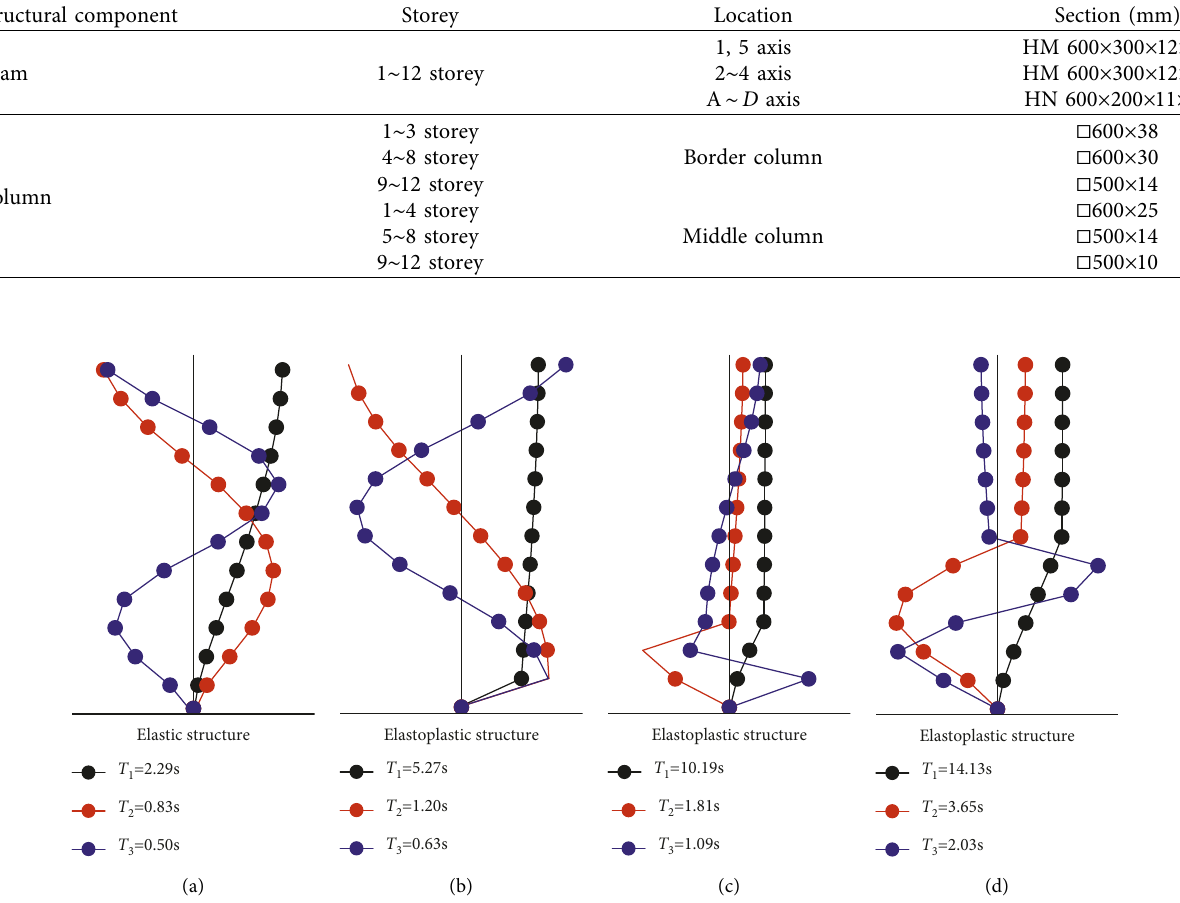
Figure 11: The first three mode shapes of the steel frame and its corresponding periods T1 ∼ T3 in X direction: (a) elastic structure; (b) elastoplastic structure with yield of the first storey; (c) elastoplastic structure with yield of the first to third storeys; (d) elastoplastic structure with yield of the first to sixth